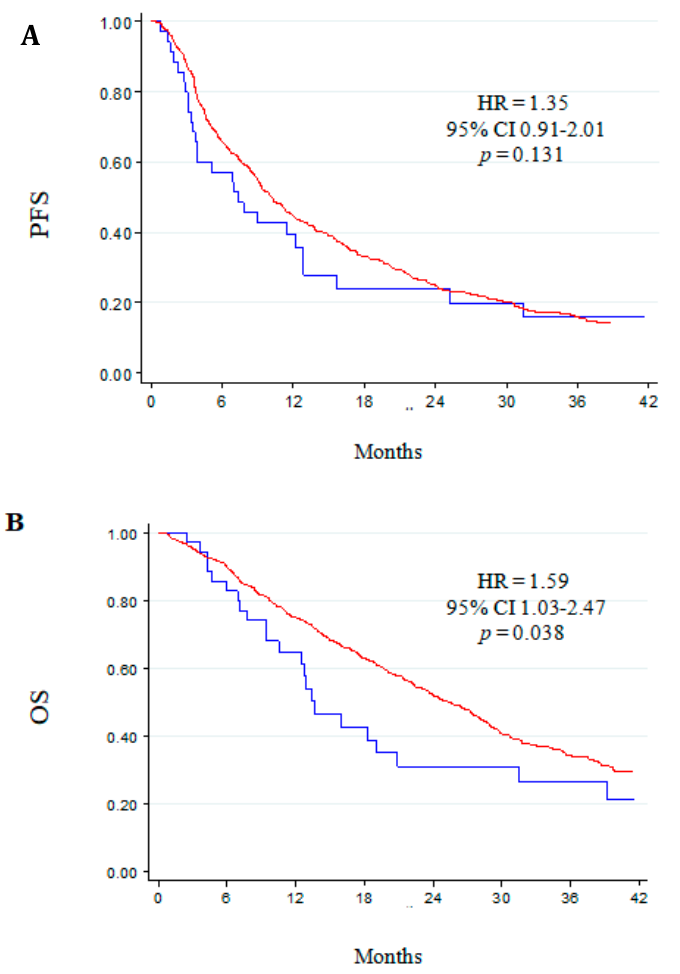
Figure 3. Clinical outcome and autoimmunity in castration-resistant prostate cancer patients treated with abiraterone or enzalutamide. Progression-free survival (PFS) ( A ) and overall survival (OS) ( B ) in patients with and without autoimmune disorders.